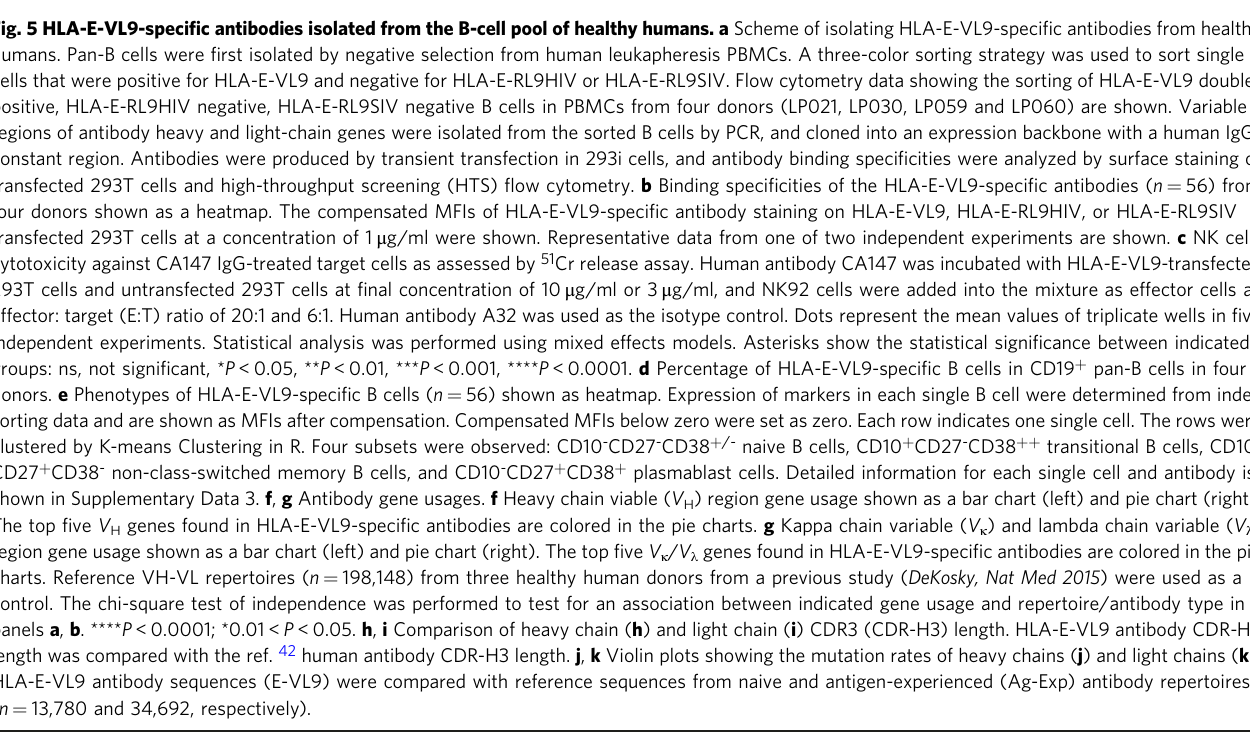
Liquid Chromatography (FPLC) system. The VH and VL sequences of mAbs were ampli fi ed from hybridoma cell RNA using primers reported previously 59,60 . Cell-surface staining and high-throughput screening (HTS) . HLA-E SCT constructs encoding HLA-E-VL9, HLA-E-RL9HIV, or HLA-E-RL9SIV were transfected into 293T cells using GeneJuice transfection reagent (Novagen, Cata- log# 70967). For epitope mapping experiment, a panel of HLA-E-VL9 SCT con- structs with single amino acid mutations were transfected into 293T cells using the same method. Cells were dissociated with 0.1% EDTA at 48h post-transfection and stained with a Fixable Near-IR Dead Cell Stain Kit (Thermo Fisher, Catalog# L34976). After washing, primary antibodies (supernatant from hybridoma cells, supernatant from transfected cells, or puri fi ed antibodies) were added and incu- bated with cells for 1 h at 4°C, following by staining with 1:1000 diluted secondary antibodies for 30min at 4°C. For mouse primary antibodies, we used Alexa Fluor 555 (AF555) conjugated goat anti-mouse IgG (H + L) (Thermo Fisher, Catalog# antibodies, we used AF555 conjugated goat anti-human IgG (H + L) (Thermo Fisher, Catalog# A-21433) or AF647 conjugated goat anti-human IgG (H + L) (Thermo Fisher, Catalog# A-21445) as secondary antibodies. Cells were then washed three times and resuspended in fi xation buffer (1% formaldehyde in PBS,